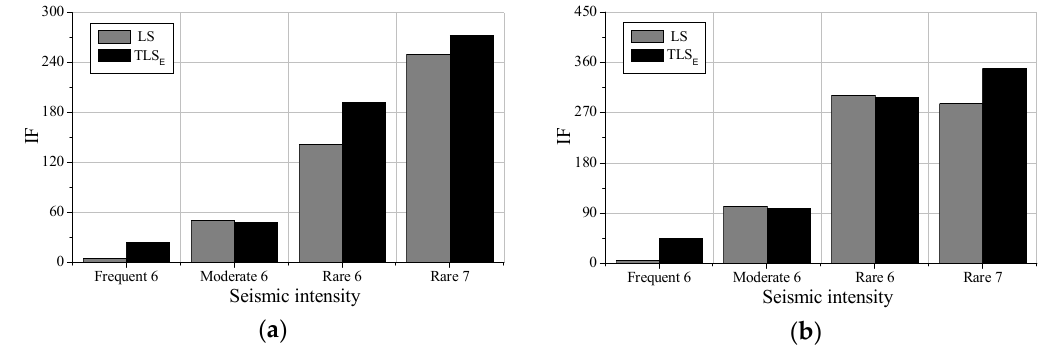
Figure 12. Comparison between least square (LS) solution with total least-squares (TLS E ) solution: ( a ) 8th story; ( b ) 50th story.